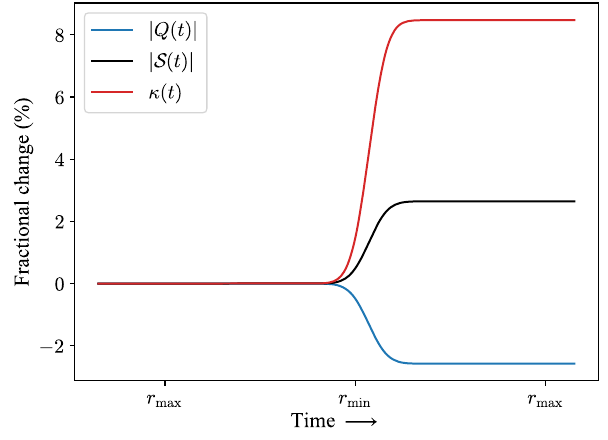
FIG. 11. Example of the evolution of the instantaneous orbit parameters in the LHC during one close approach to the beam. The grain is subject to a positive charging current, but the net charge remains